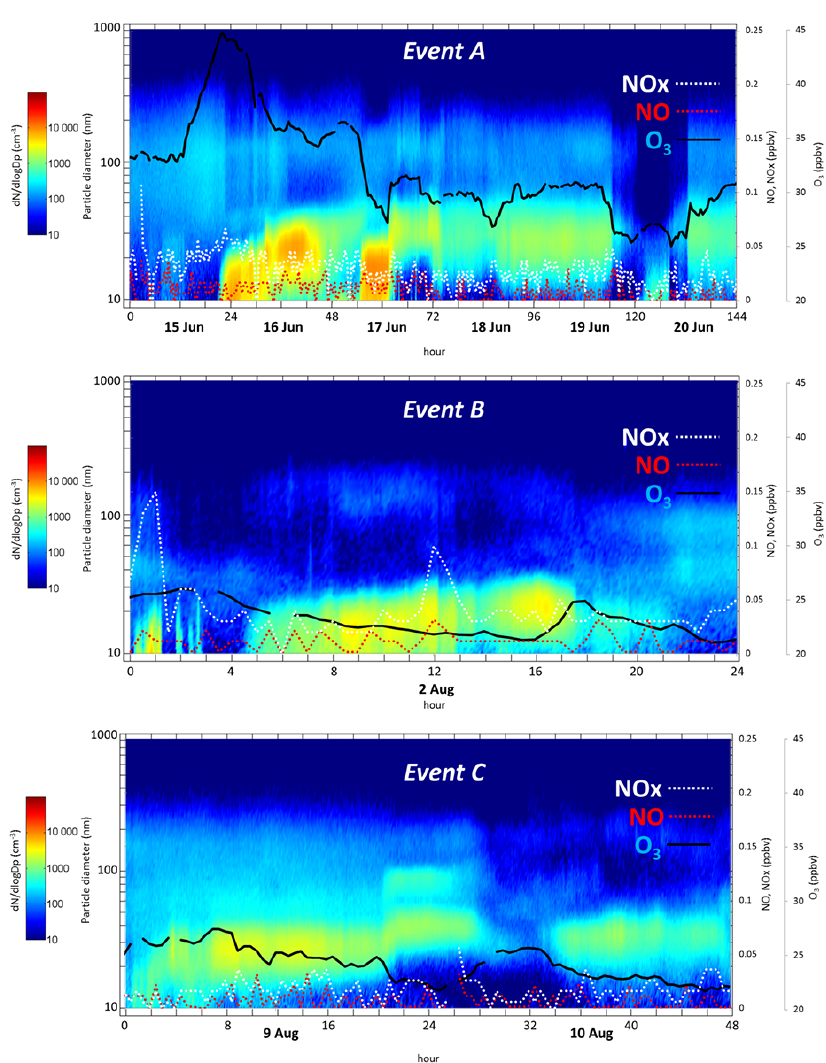
Figure 6. Demonstration of the impacts of O 3 , NO and NO x on the summer new particle formation events occurring on 15–20 June (Event A), 2 August (Event B) and 9–10 August (Event C) in